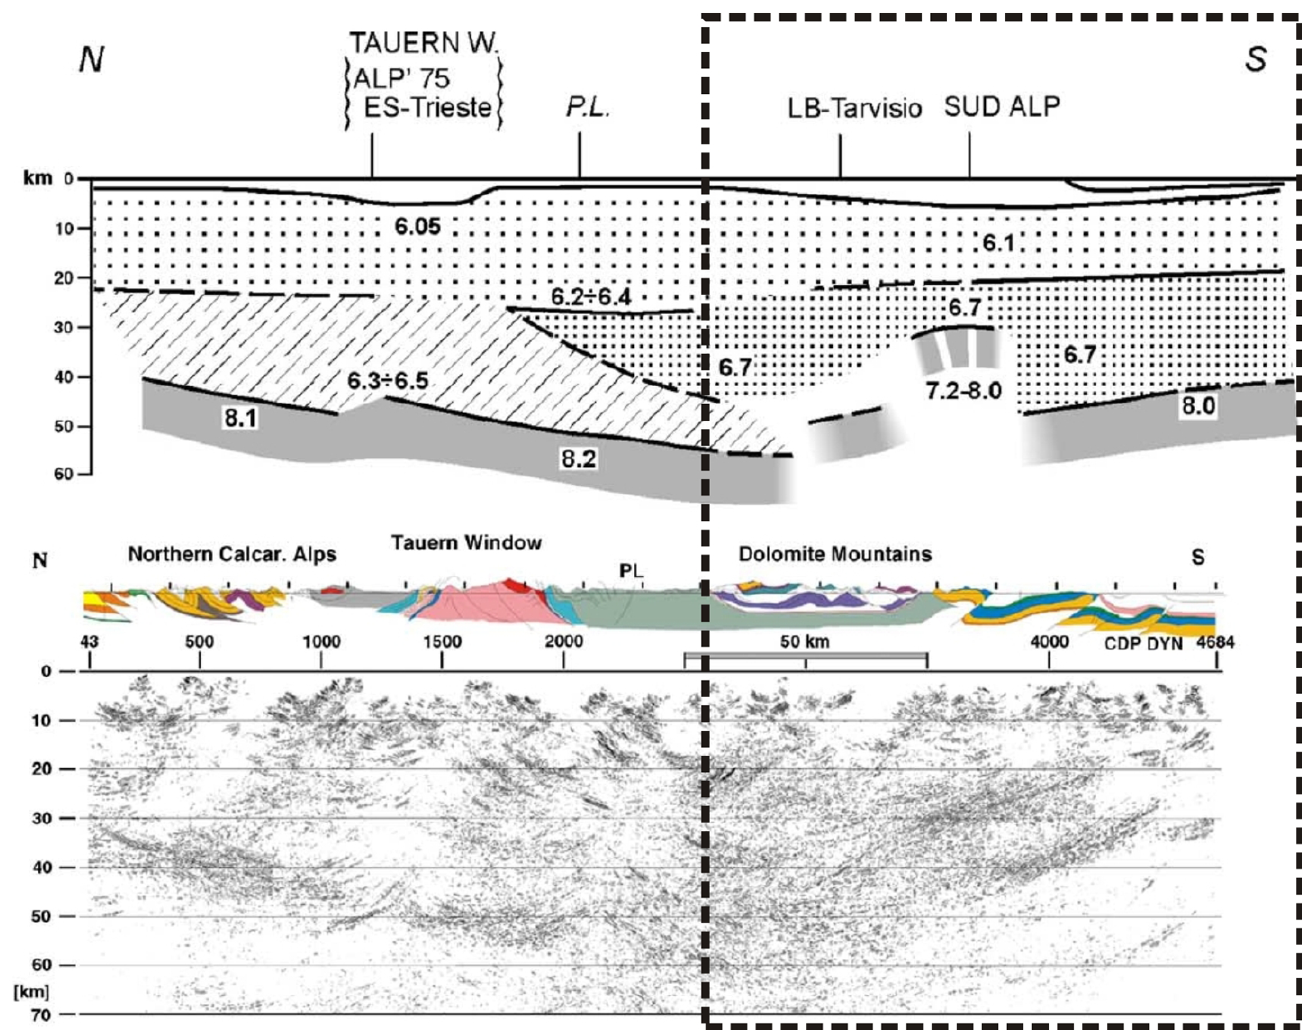
Figure 3. Geological model proposed by Cassinis [2006] (top) and depth-converted seismic section by Lueschen et al. [2005] (bottom). Dotted line, area covered by the models in Figures 1 and 2 along the Transalp profile (modified from Cassinis